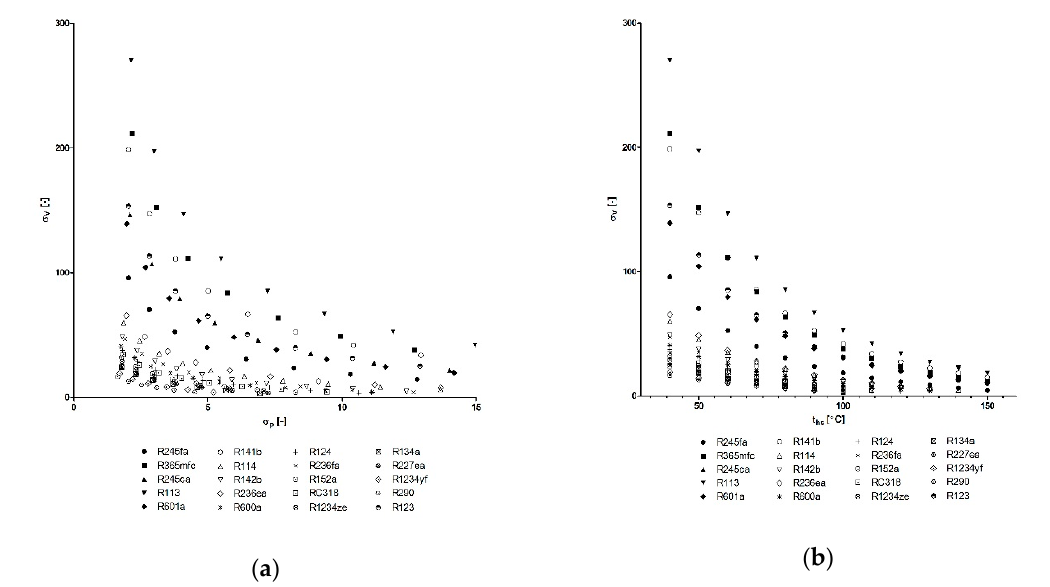
Figure 16. The variation of the σ V parameter vs. the pressure expansion ratio and heat source temperature: ( a ) σ V = f( σ P ); ( b ) σ V = f(t hs ).